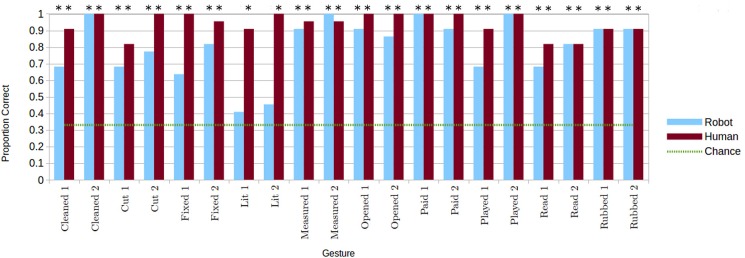
Proportion of correct identifications of each gesture for the two performance conditions, when gestures are presented alone. Correct gesture identifications significantly greater than chance indicated with *p < 0.05. © 2015 IEEE. Reprinted, with permission, from Bremner and Leonards (2015a).